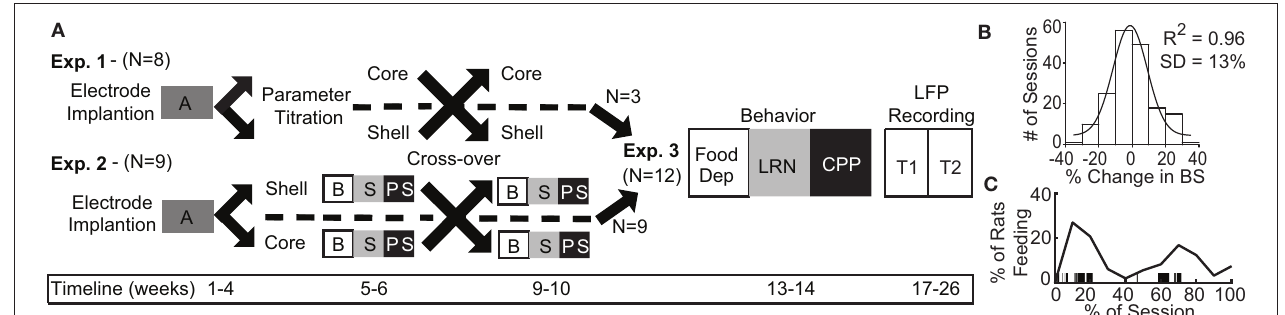
FIGURE 1 | Experimental design and timeline with population data used to define significant change in binge size from baseline. (A) Experimental design for Experiments 1–3 with timeline shown at bottom. A, acquisition of stable binge size following chronic irregular limited access and randomization to initial stimulation target; B, baseline sessions; S, stimulation sessions; PS, post-stimulation sessions; Food Dep, food deprived binge session; LRN, locomotor response to novelty; CPP, conditioned place preference; LFP Recording, local field potential recording at two time points (T1 and T2). (B) Population baseline data (3 sessions per animal, N = 36 animals) was used to determine an a priori definition of a significant change from baseline binge size (BS). Distribution of binge size variance across baseline sessions was fit to a normal distribution with R 2 fit shown (1 standard deviation [SD] = 13% change from baseline average). (C) The percentage of animals engaged in feeding behavior through a normalized binge session had a bimodal distribution. Vertical black lines under the curve provide an individual example of all of the feeding epochs from a single animal through a binge